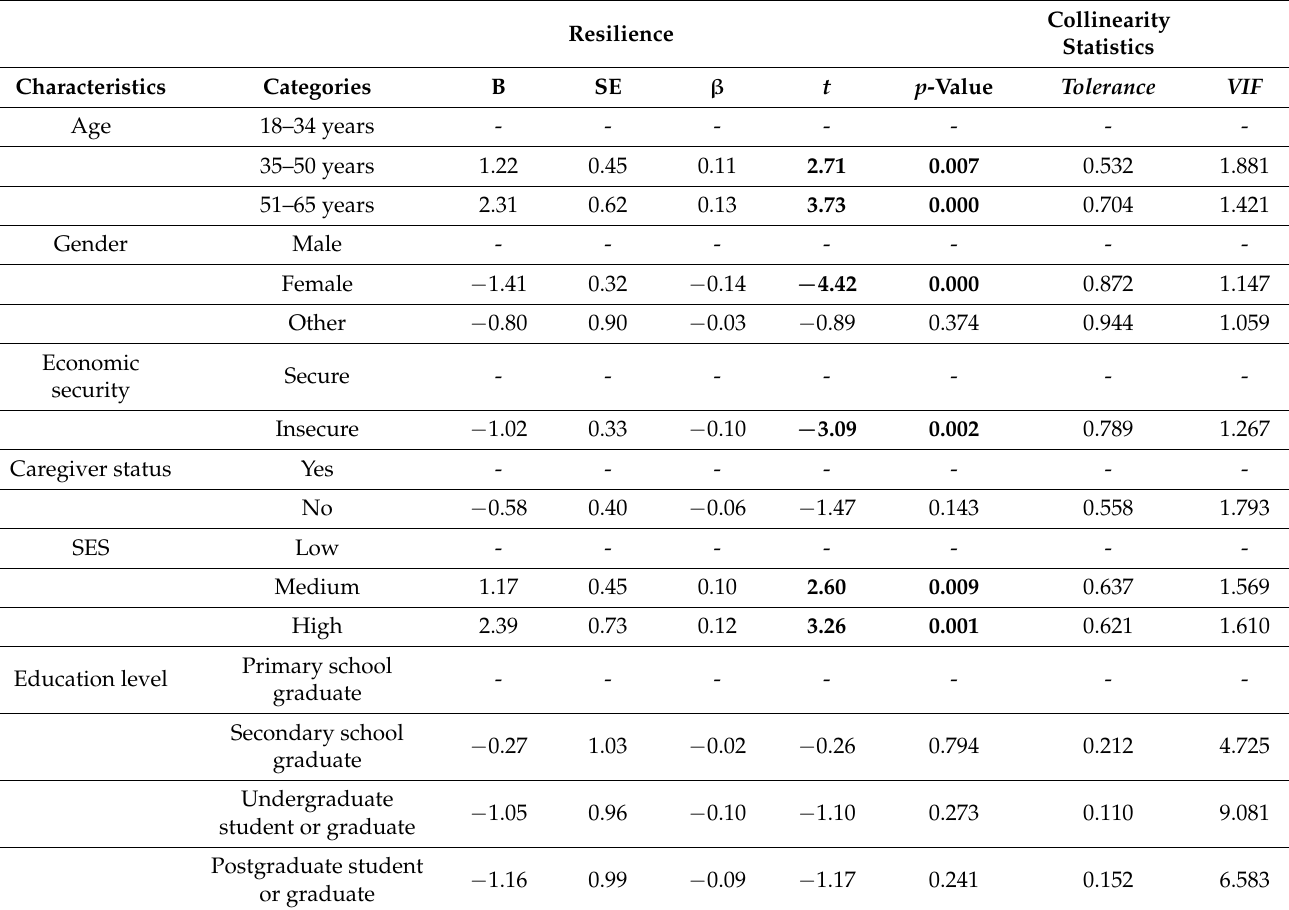
Table 2. Results of multiple regression analysis for resilience ( N =